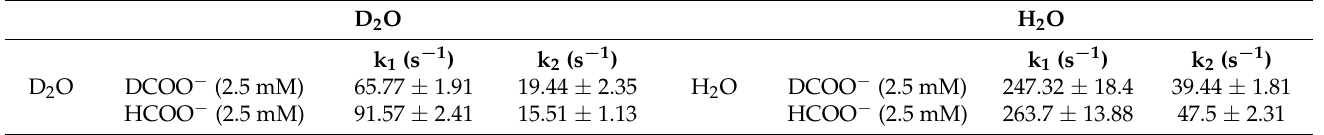
Table 2. The effect of deuterated solvent and the substrate on the reductive half-reaction of FDH. Rapid reaction kinetic measurements were carried out using a stopped-flow spectrophotometer. A total of 2.5 µ M of Rc FDH under anaerobic conditions with either D 2 O or H 2 O containing 50 mM phosphate buffer pH/pD 7.9 was used. Formate and deuterated formate (2.5 mM each) were used. Rapid reaction kinetics were obtained by following changes at 445 nm for 2.2 s. k 1 and k 2 are the first and second kinetic constants obtained for the reductive half-reaction after a triphasic fit. The slowest third phase was not included as it is independent of formate concentration [15]. D 2 O H 2